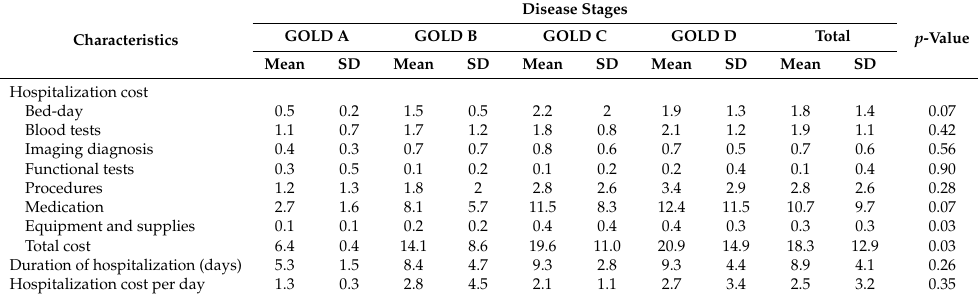
Table 2. Cost categories according to disease stages ( n = 57). Unit: Million VND.